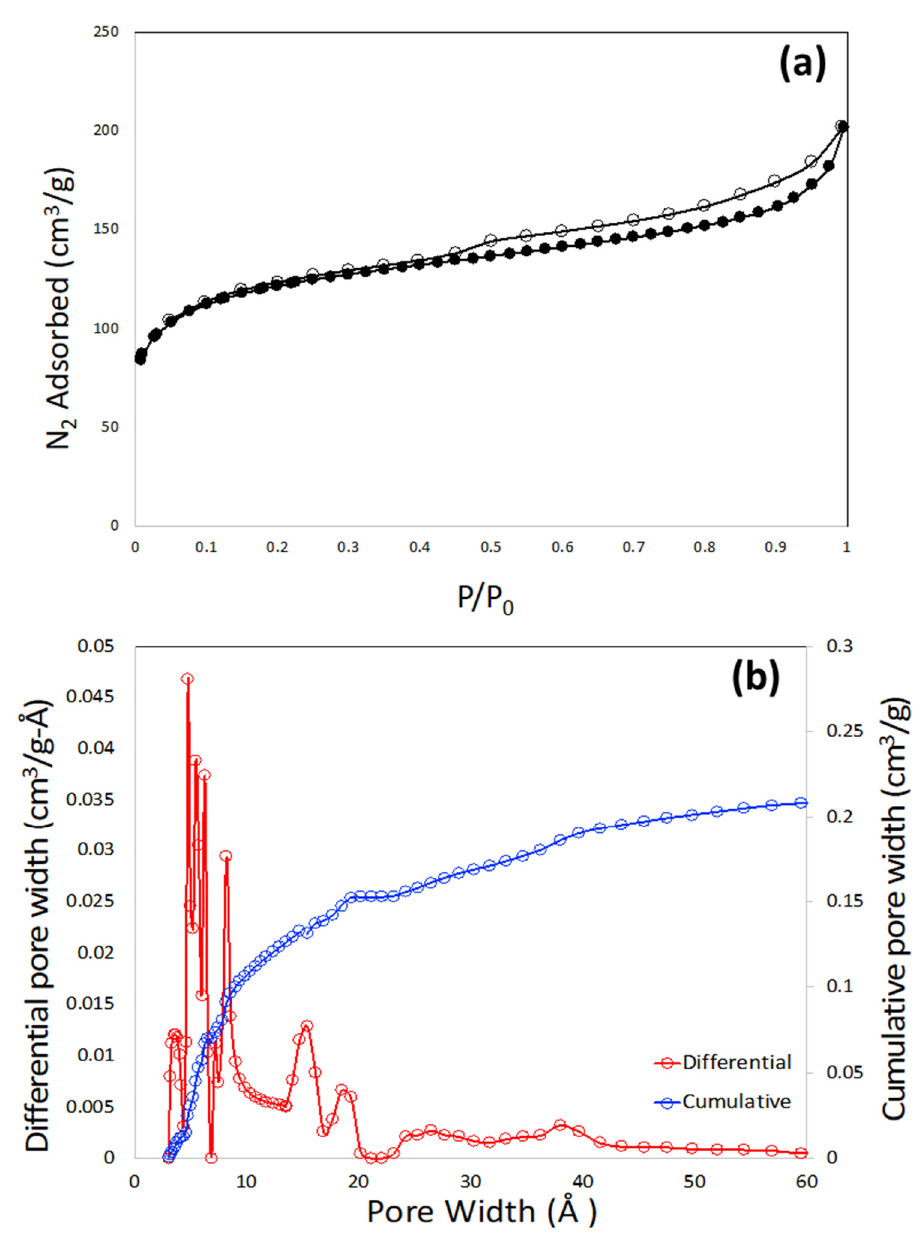
Figure 6. N 2 adsorption-desorption plot at 77 K ( a ) and pore size distribution plot ( b ) of 3D printed porous carbon monolith.